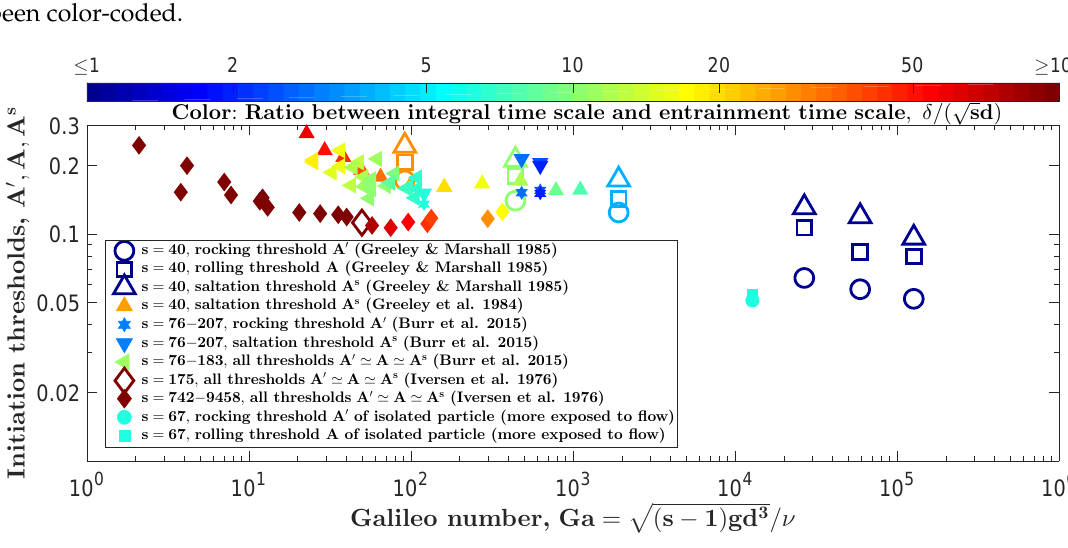
Figure 2. Measurements of the rocking ( A (cid:48) ), rolling ( A ), and saltation ( A s ) threshold parameters from the literature [15,41,53,55] and ourselves (isolated-particle measurements, see Figure 3) versus the Galileo number Ga. The color indicates the value of the dimensionless boundary layer thickness √ sd ) , which is a measure for the ratio between the integral time scale T i and the entrainment time δ / ( scale T e